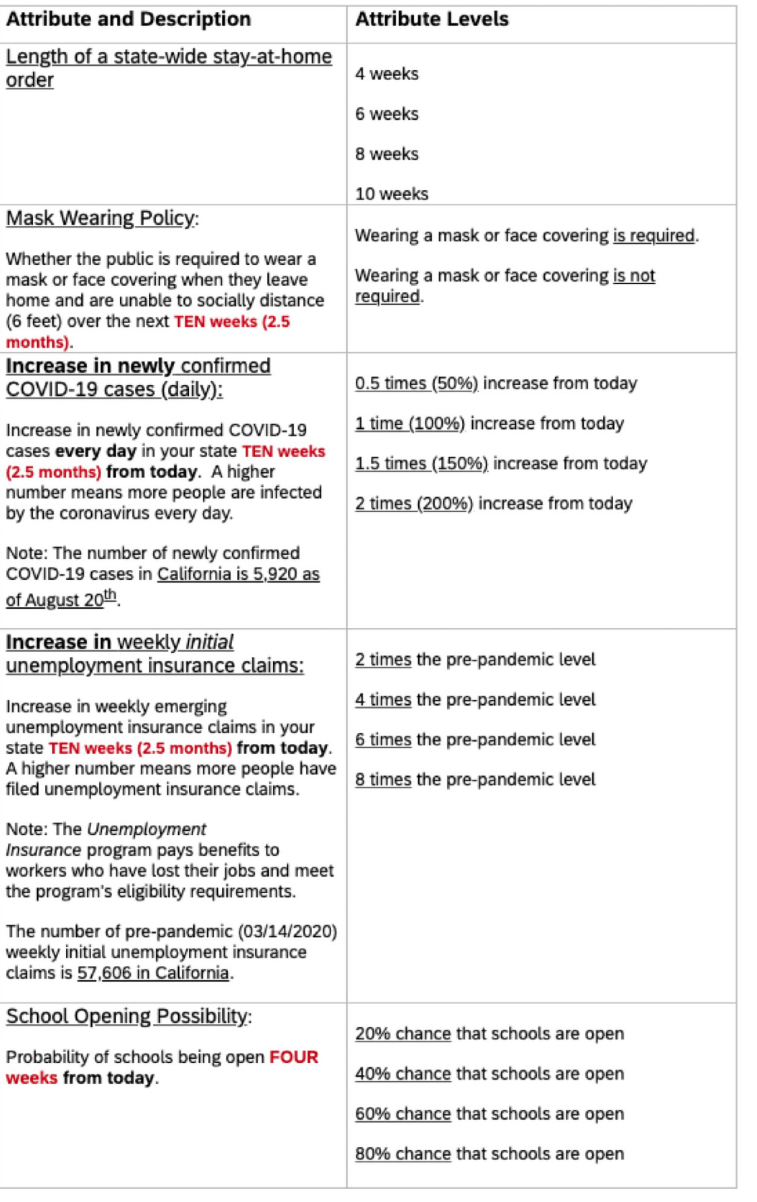
Fig 2. Attribute levels in the discrete choice experiment